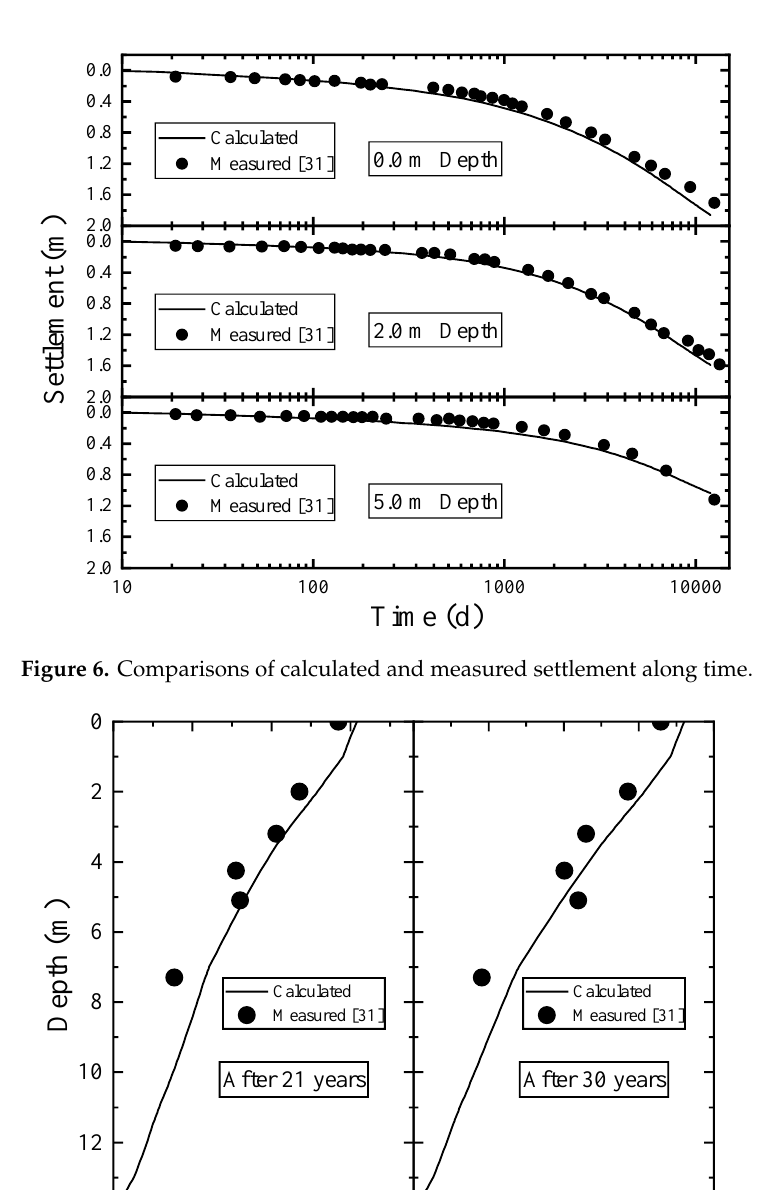
Figure 5. Comparisons of calculated and measured excess pore water pressure along depth.